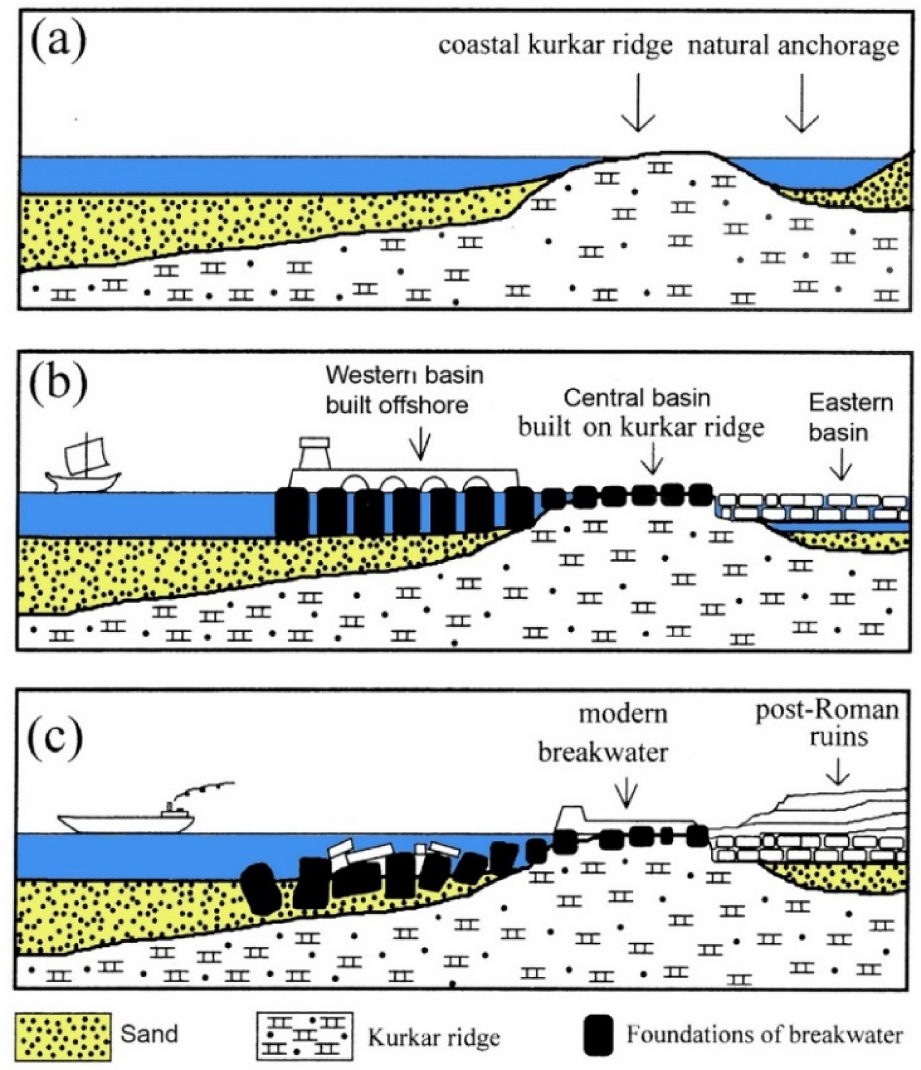
Figure 16. A schematic cross-section model demonstrating the paleogeography and the submergence of the western basin of the Caesarea harbor: ( a ) before the construction of the harbor, ( b ) the three basins of the harbor when functioning, ( c ) the present situation, the western basin has settled and is currently submerged